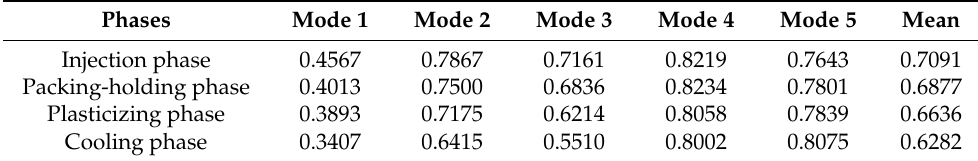
Table 2. Phase mean value R 2